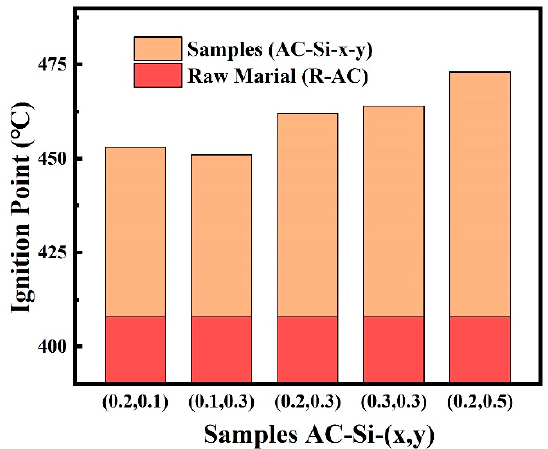
Figure 9. The ignition points of raw material and di ff erent samples.